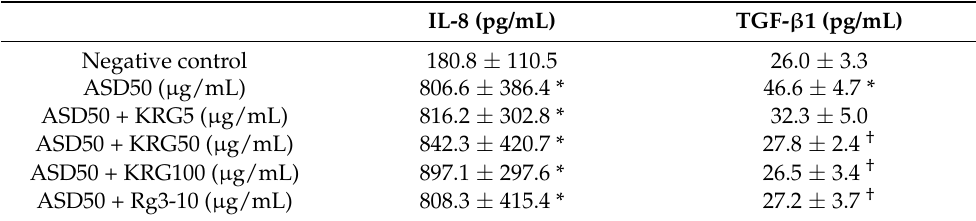
Table 1. The effect of Asian sand dust (ASD), Korean red ginseng (KRG), and ginsenoside Rg3 on IL-8 and TGF- β 1 production from nasal epithelial